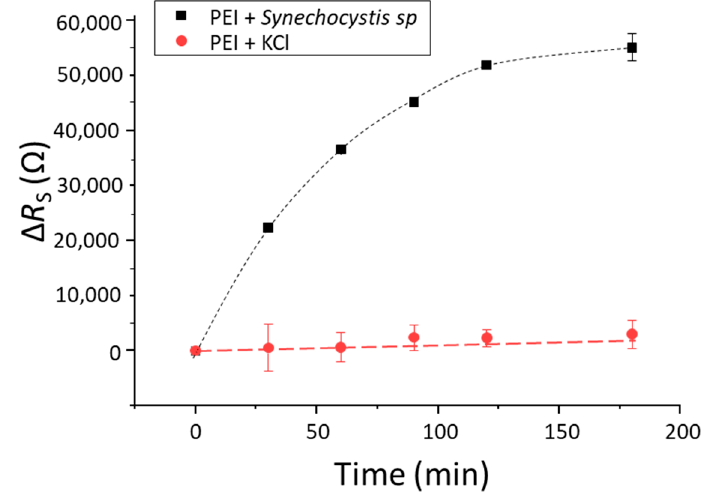
Figure 3. Impedance response ( R S ) in time of PEI modified electrodes with cyanobacteria at 10 4 cells/mL (black squares) and in absence of cyanobacteria (red circles). Error bars show standard deviation (n = 3).